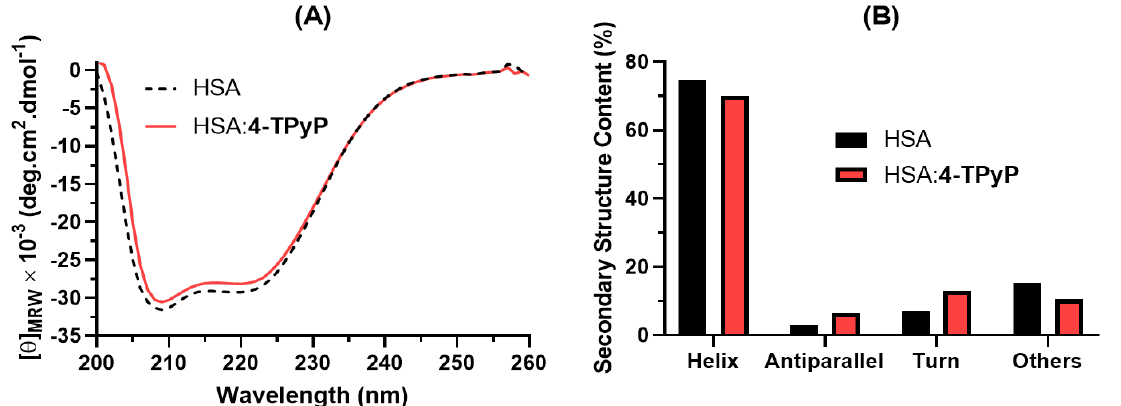
Figure 5. ( A ) Far-UV CD spectra for HSA without and with 4-TPyP in PBS (pH 7.4) at 310K. ( B ) Secondary structure content for HSA without and with 4-TPyP determined by the online server BestSel (Beta Structure Selection http://bestsel.elte.hu/index.php (accessed on 2 June 2022)). [HSA] = 1.0 × 10 − 6 M and [4-TPyP] = 1.32 × 10 − 5 M.